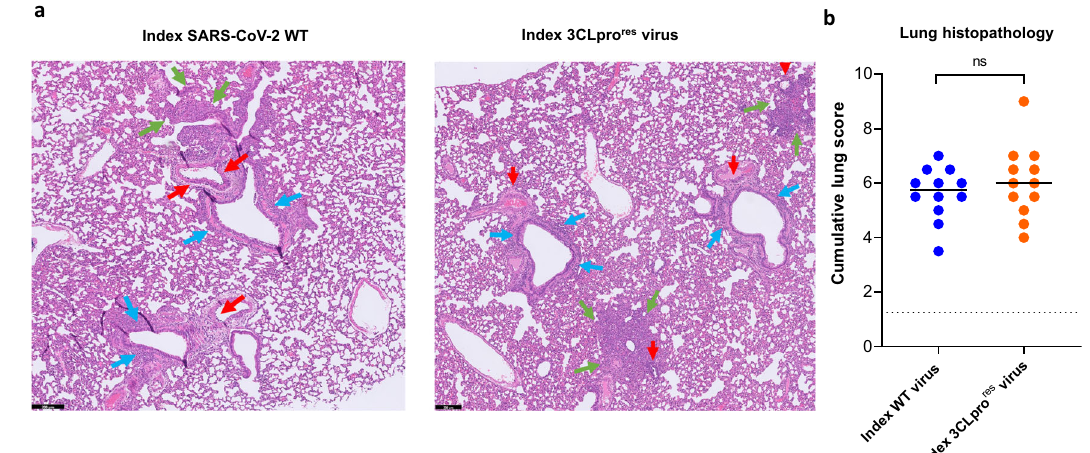
Fig. 2 | Histopathology of lungs of Syrian hamsters infected with either the wild-type SARS-CoV-2 or the 3CLpro (L50F-E166A-L167F) resistant virus. a Representative H&E images of lungs of hamsters infected with 10 4 TCID 50 of either the wild-type (WT) SARS-CoV-2 virus (USA-WA1/2020) or the 3CLpro (L50F- E166A-L167F) nirmatrelvir resistant (3CLpro res ) virus at day 4 post-infection (pi) showingperibronchialin fl ammation(bluearrows),peri-vascularin fl ammationwith vasculitis (red arrows), and foci of bronchopneumonia (green arrows). Scale bars,